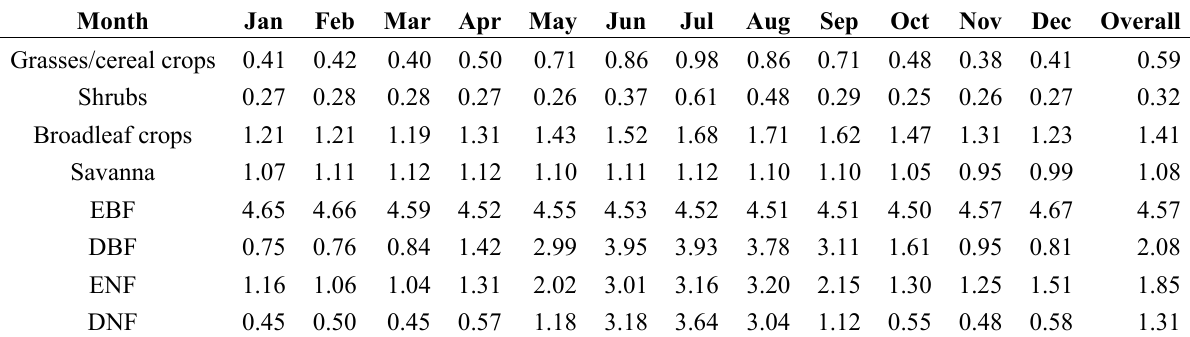
Table 4. Global LAI climatologies for the eight biome types derived from pure pixels (2003 − 2009). Month Jan Feb Mar Apr May Jun Aug Sep Oct Nov Dec Overall Grasses/cereal crops 0.41 Shrubs 0.27 Broadleaf crops 1.21 Savanna 1.07 EBF DBF 0.75 ENF